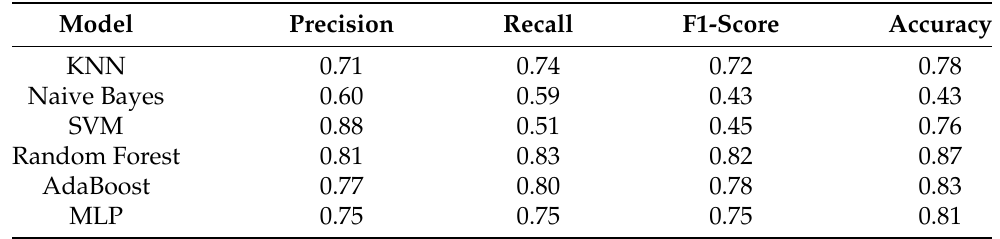
Table 10. Classification Results NLP + Titles.